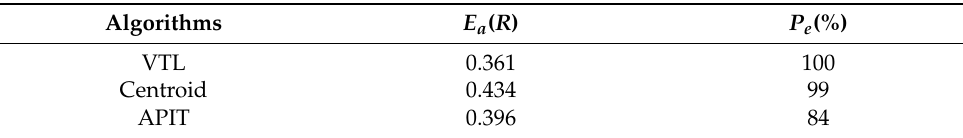
Figure 10. Comparison of simulation outcomes of three algorithms at the same square topology ( S = 100 × 100 m 2 , N t = 140, N a = 40, R a = R = 20 m, E GPS = 0, K = 6). ( a ) WSN node distribution. ( b ) Centroid. ( c ) APIT. ( d ) VTL. Table 4. Performance comparison (Figure